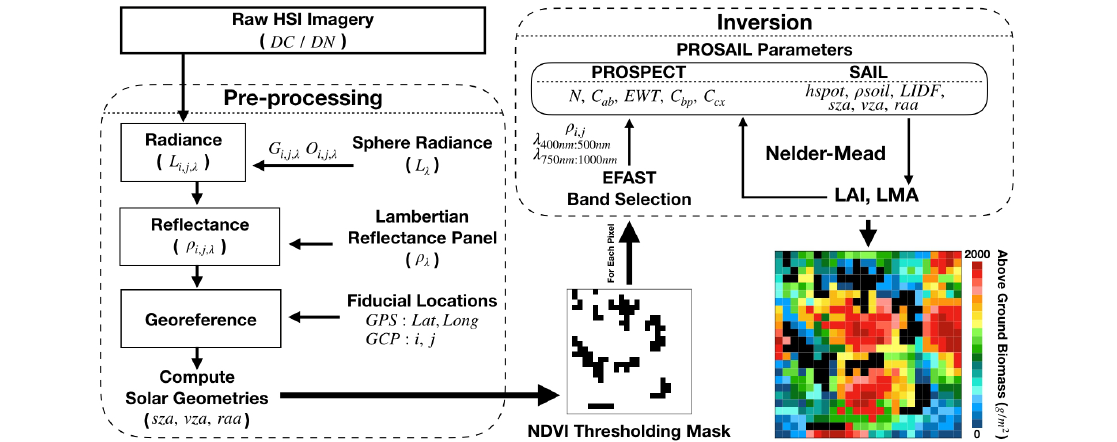
Figure 4. Overview of the inversion scheme to retrieve aboveground biomass of Spartina alterniflora from imagery collected by a ground-based HSI system. After data preprocessing, the NDVI threshold mask is used to remove soil pixels from the image in the analysis. EFAST provides band selection, while optimization of the PROSAIL model to obtain LAI and LMA uses the Nelder–Mead algorithm